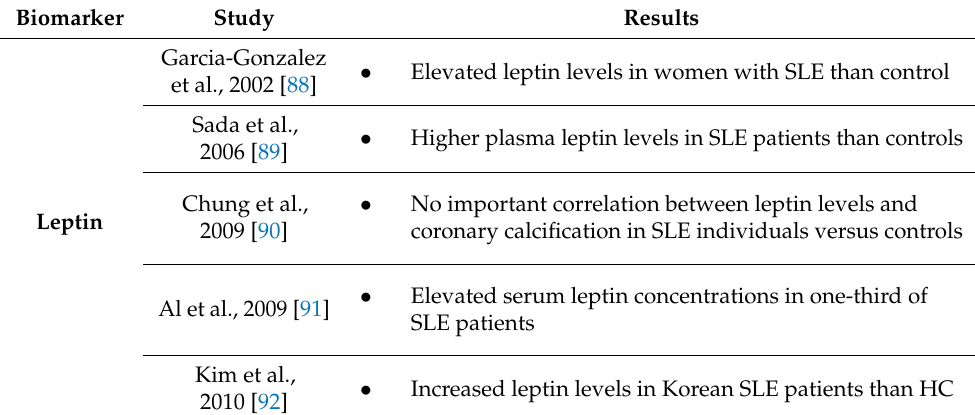
Table 4. Leptin and SLE